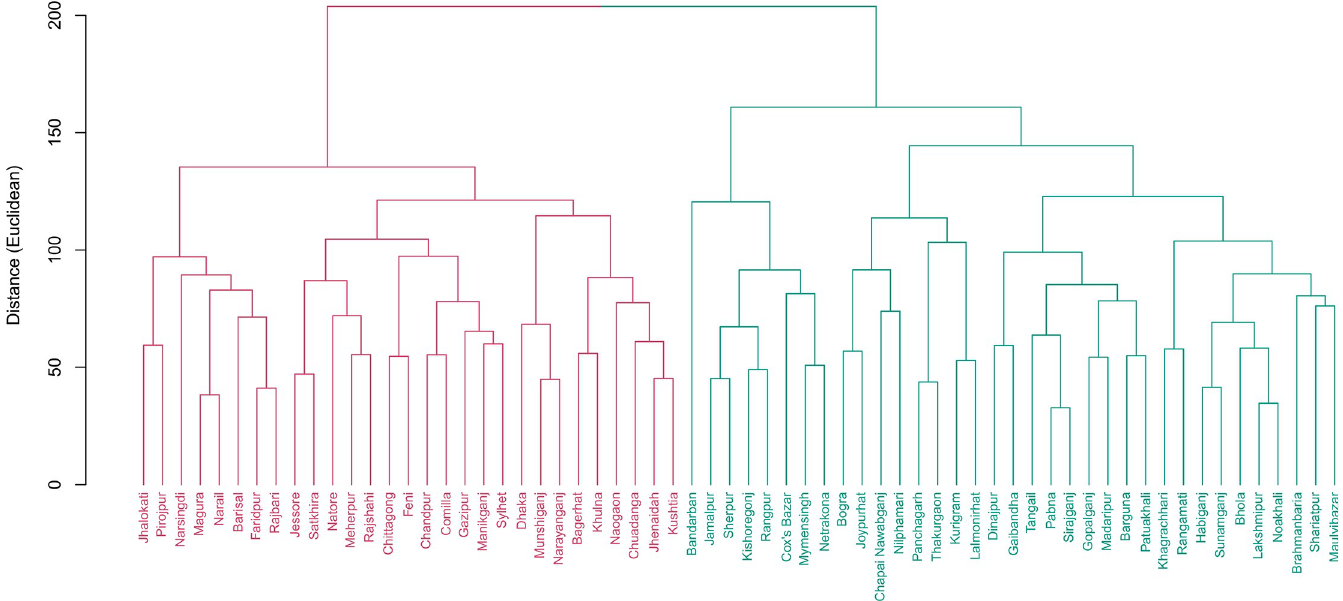
Fig 6. Cluster of districts based on all indicators combined. There are 29 districts in cluster 1 and 35 districts in cluster 2.